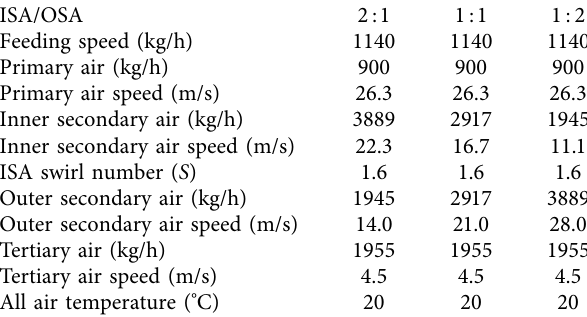
Table 2: Experimental conditions and